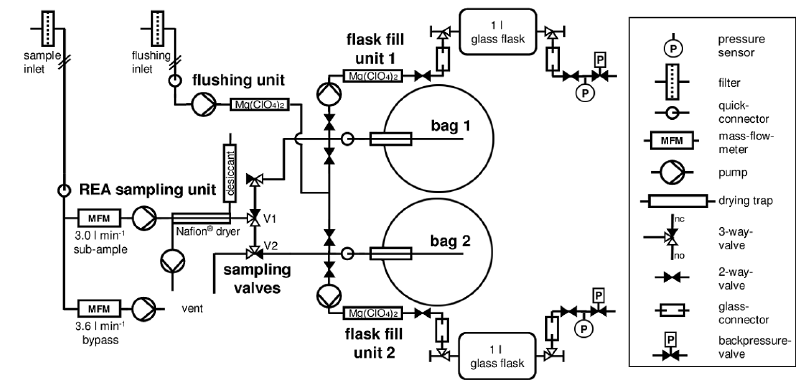
Figure 1. Design of the whole-air REA system (Ruppert et al.,